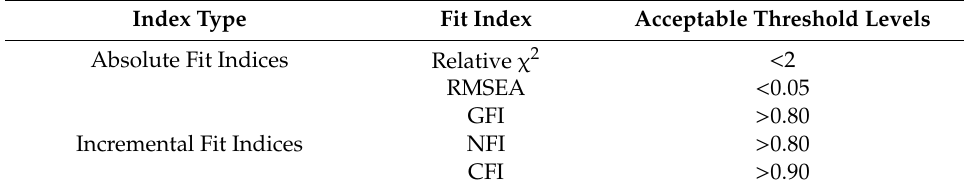
Table 6. Acceptable threshold levels of fit indices of the structural equation model.